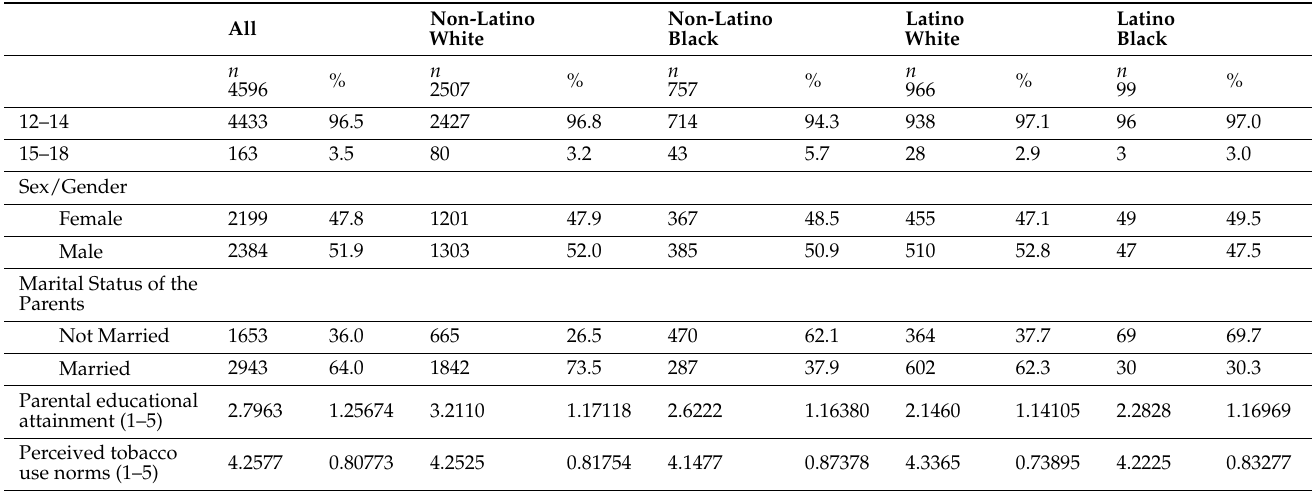
Table 1. Descriptive data overall and by race in youth ( n = 4329).